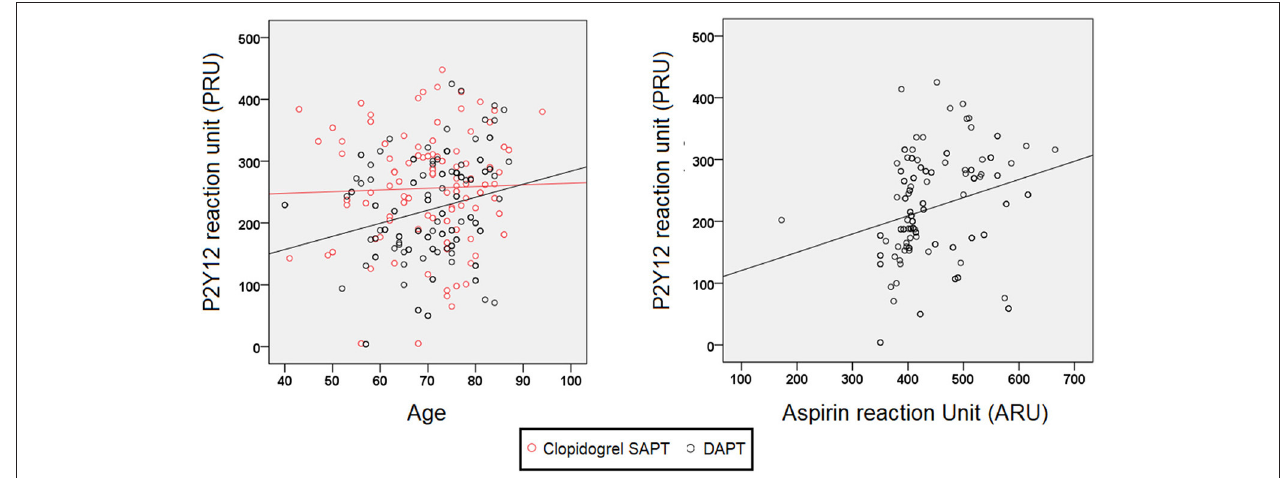
FIGURE 2 | PRUs stratified by age and ARU in recurrent stroke patients receiving